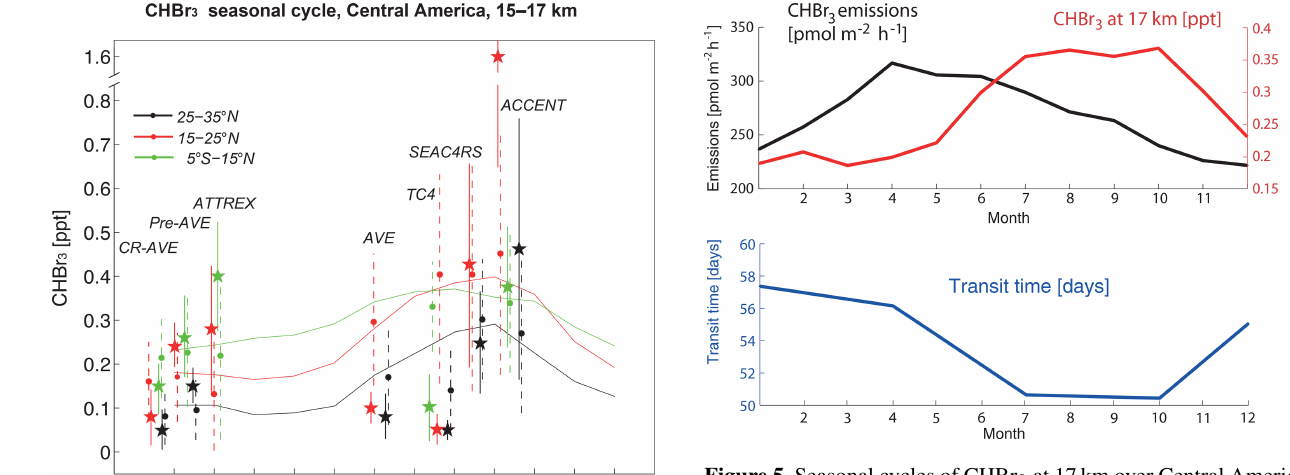
Figure 5. Seasonal cycles of CHBr 3 at 17km over Central America (black square in Fig. 2a) from FLEXPART simulations (red line), oceanic CHBr 3 emissions averaged over the respective source re- gion (black line), and the “surface–17km” mean transit time (blue line) are